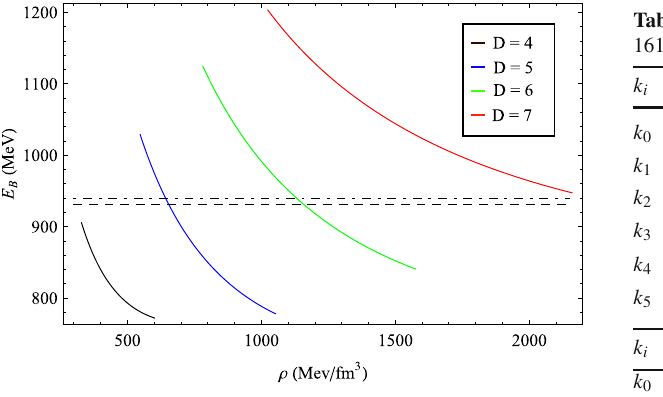
Fig. 16 Variation of energy per baryon ( E B ) with density ( ρ ) for HER X-1. Here the dashed line represents energy per baryon of 56 Fe which is 930.4 MeV and dot dashed line corresponds to the mass of nucleons (939 MeV)